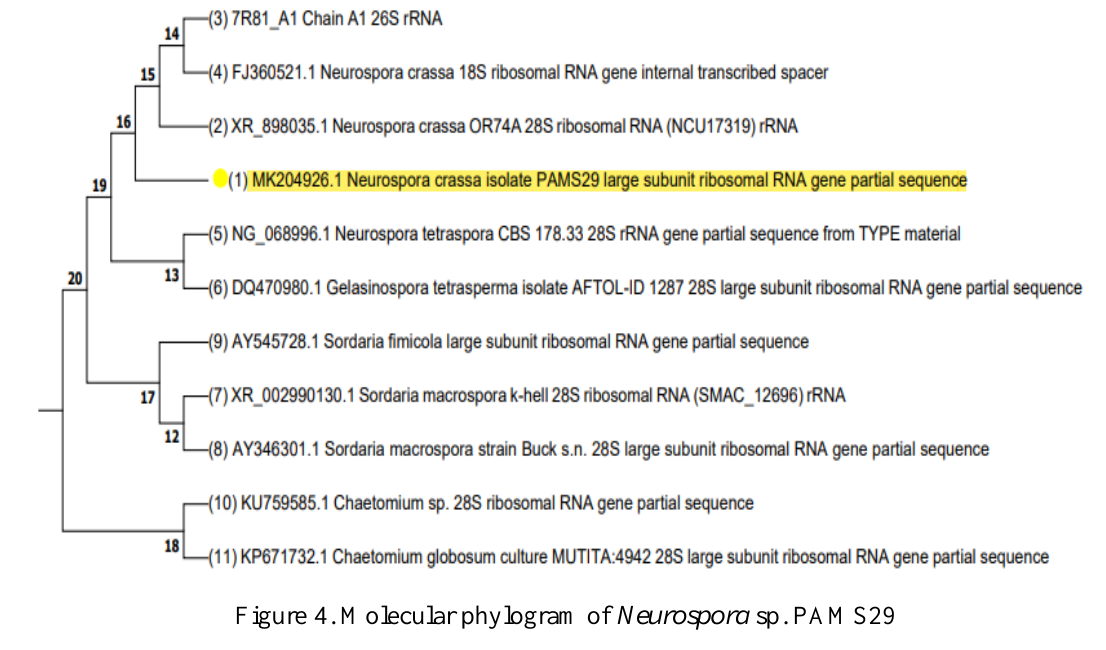
Figure 4. Molecular phylogram of Neurospora sp. PAMS29 * Yellow color shows the query